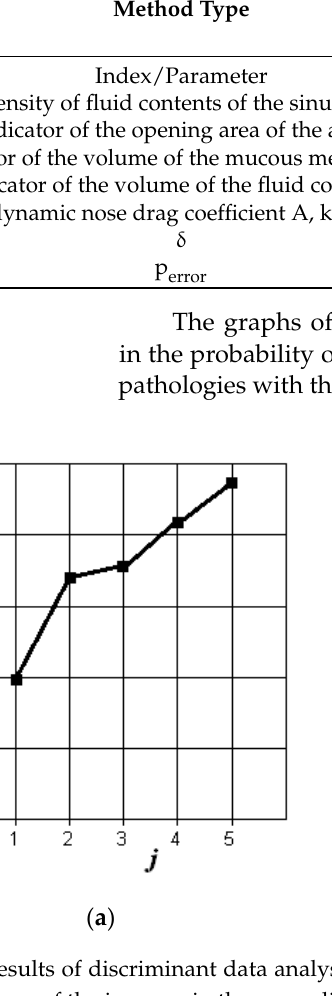
( b ) Figure 7. The results of discriminant data analysis when comparing the norm with acute purulent odontogenic sinusitis: ( a ) the dependence of the increase in the normalized Euclidean distance as signs are added to the discrimination model F(j)   ; ( b ) the dependence of the decrease in the probability of a decision error as signs are added to the discrimination model er P f(j)  : j = 5 ‐ is the dimension of the space of informative parameters.